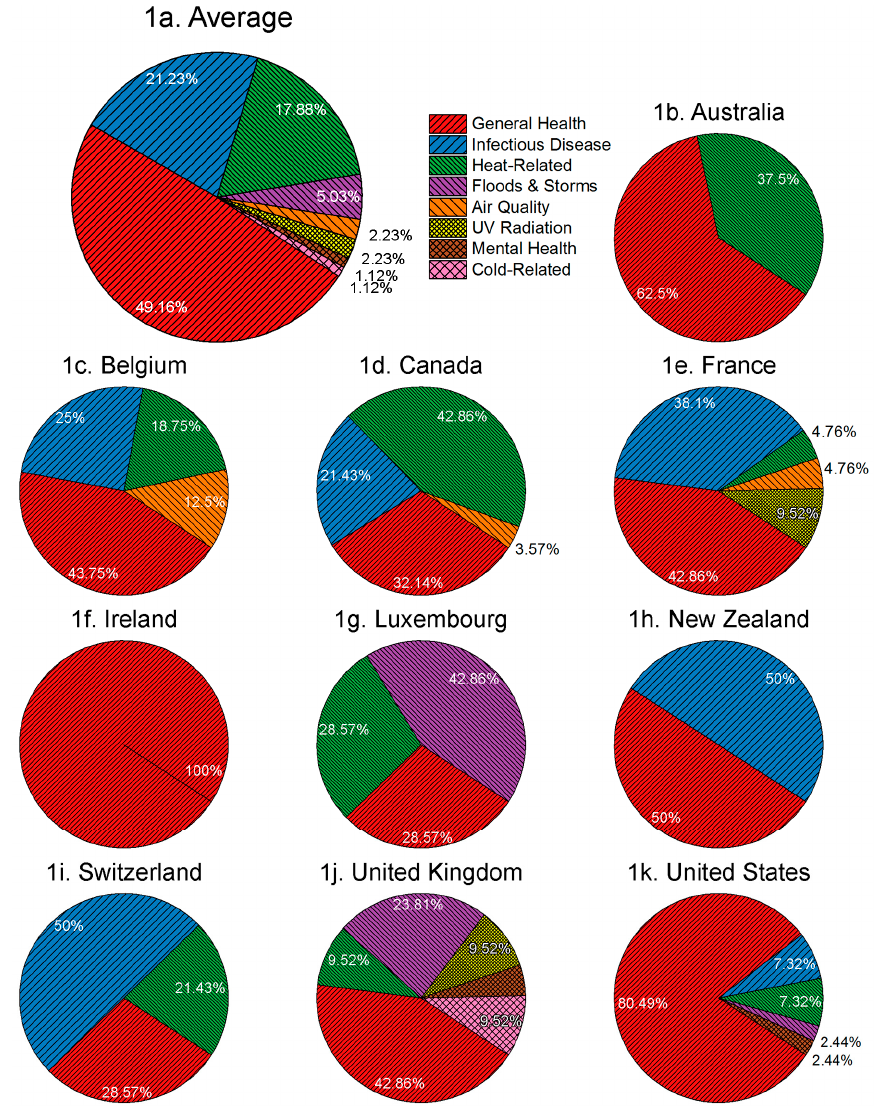
Figure 1. Percentage of health risks addressed by identified health adaptation initiatives.